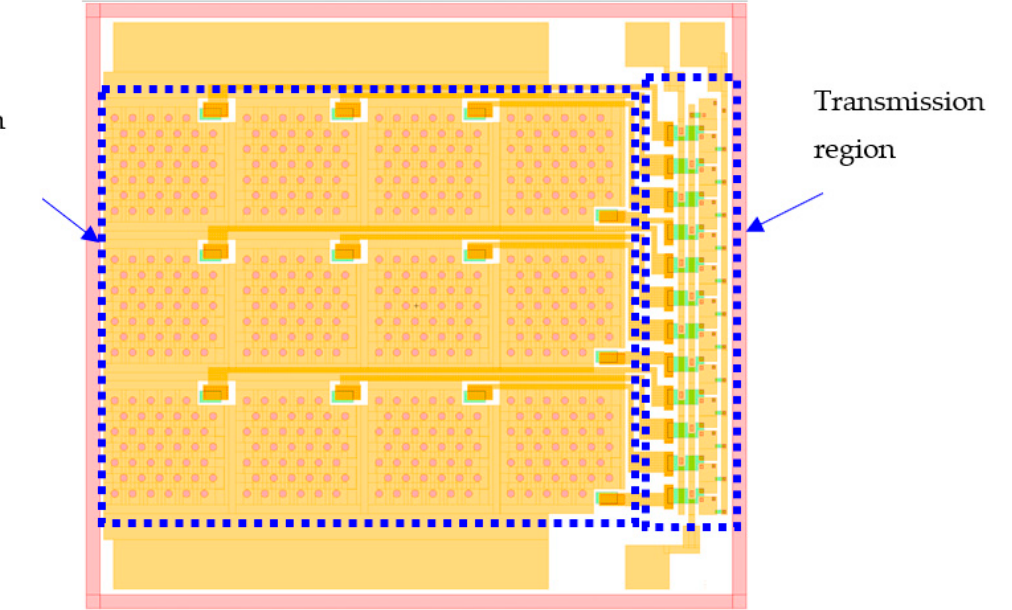
Figure 4. Schematic drawing of the proposed all-monolithically integrated self-scanning addressable VCSEL array for ToF measurement.